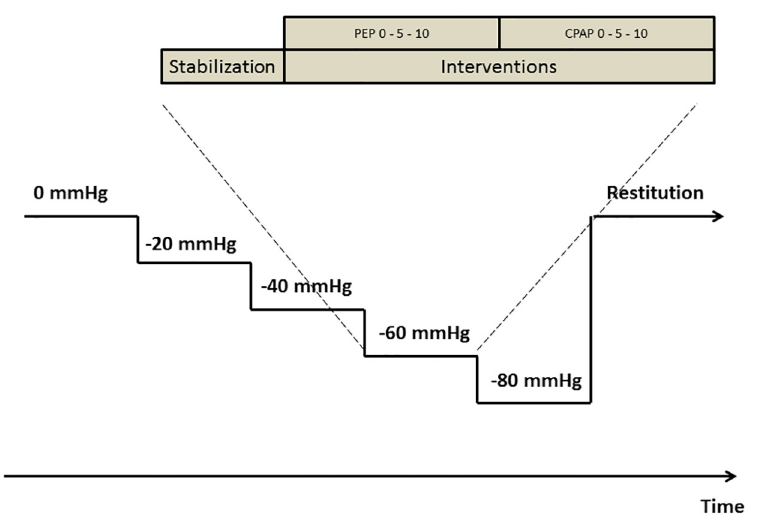
Fig 1. Protocol. Each LBNP-level lasted for approximately 6 min and consisted of 1 min stabilization and minimum 5 breaths at each level of PEP and CPAP. PEP- and CPAP-levels were assigned in randomized order. PEP : positive expiratory pressure, CPAP : continuous positive airway